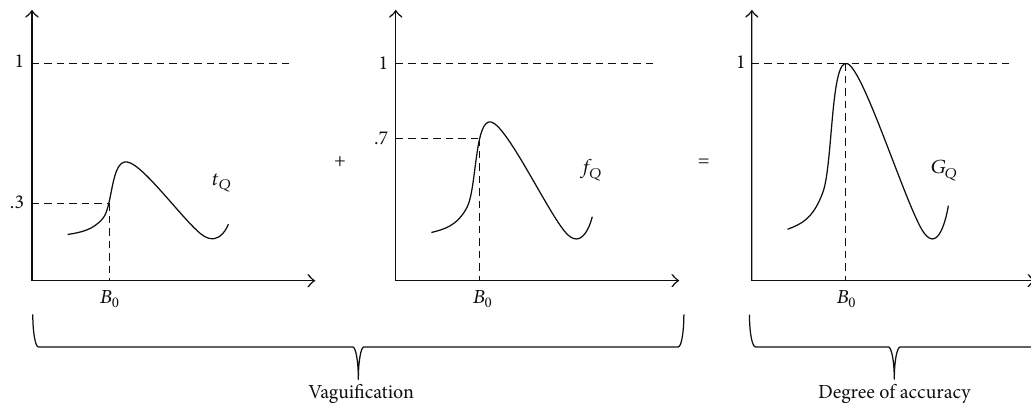
Figure 8: Vaguification to degree of accuracy (Sample Task Set).